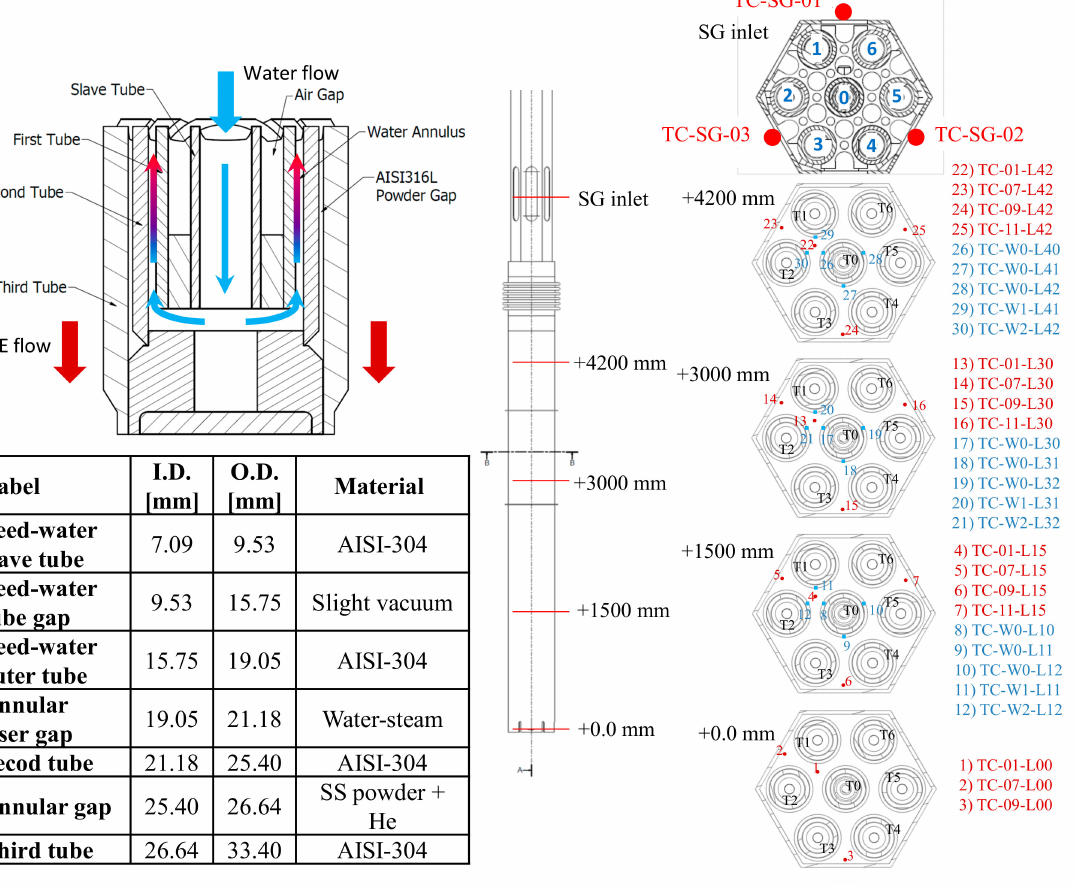
Figure 2. Details of the bayonet tube geometry and SGBT primary side